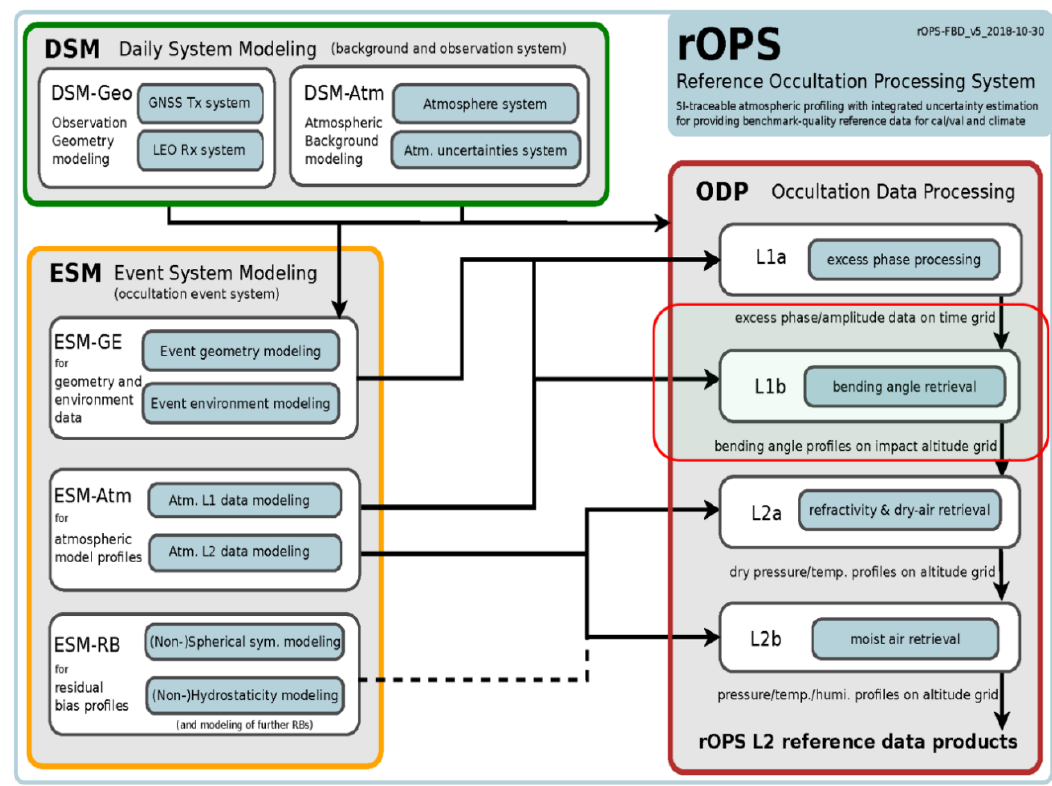
Figure 2. Overview of the reference occultation processing system (rOPS) in the form of a functional block diagram, illustrating the logic of the system modeling and data analysis approach, indicating its main subsystems and the occultation data processing with the processors, highlighting the level 1b (L1b) data processor where the bi-local bending angle residual ionospheric error (RIE) correction is implemented with the red box.